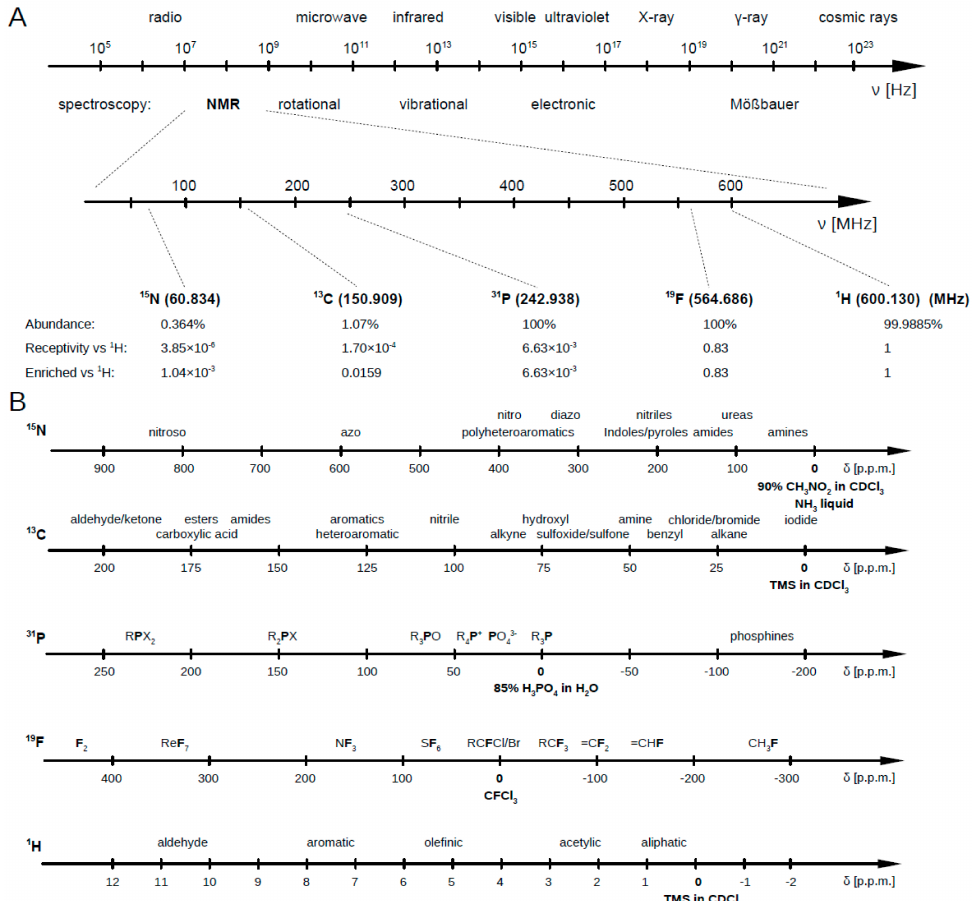
Figure A1. ( A ) Spectroscopies and corresponding frequency ranges. Larmor frequency of most used nuclei for metabolomics analyses with respect to that of the proton when at 600 MHz. ( B ) Parts per million intervals for all these nuclei ( 15 N, 13 C, 31 P, 19 F and 1 H) at characteristic chemical environments. Figure reprinted from Ref. [3] under the terms of the Creative Common CC-BY